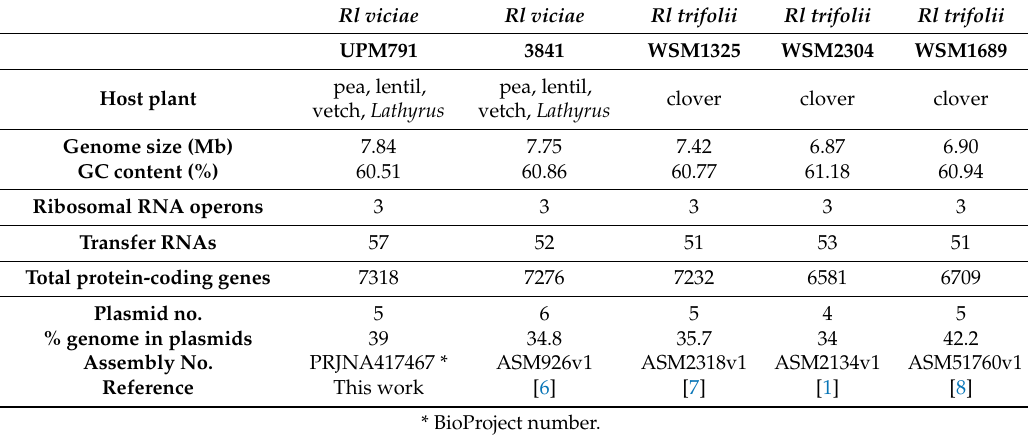
Table 1. General features of Rhizobium leguminosarum ( Rl ) complete genome sequences (data from IMG/M database).